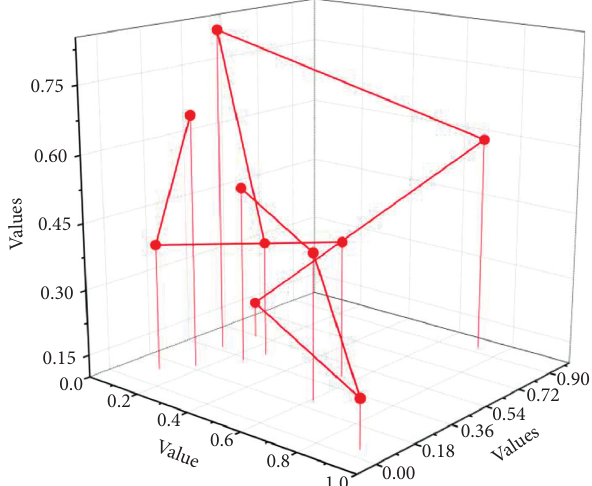
Figure 11: Grid handle simulation optimal value of the hyperparameters of the algorithm is obtained, k � 270, m � 2, and the mean value of the score is the highest at 0.8362.